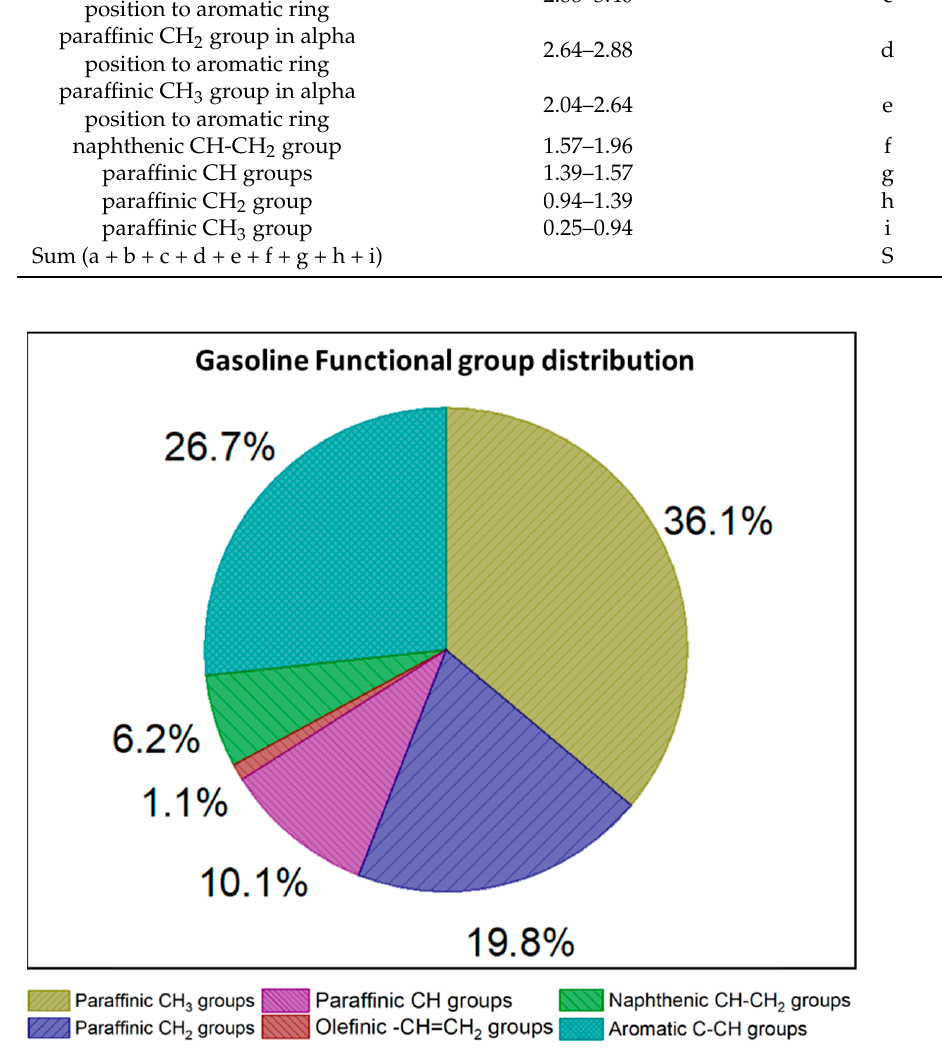
Figure 2. Mass % of the functional groups present in the gasoline sample.